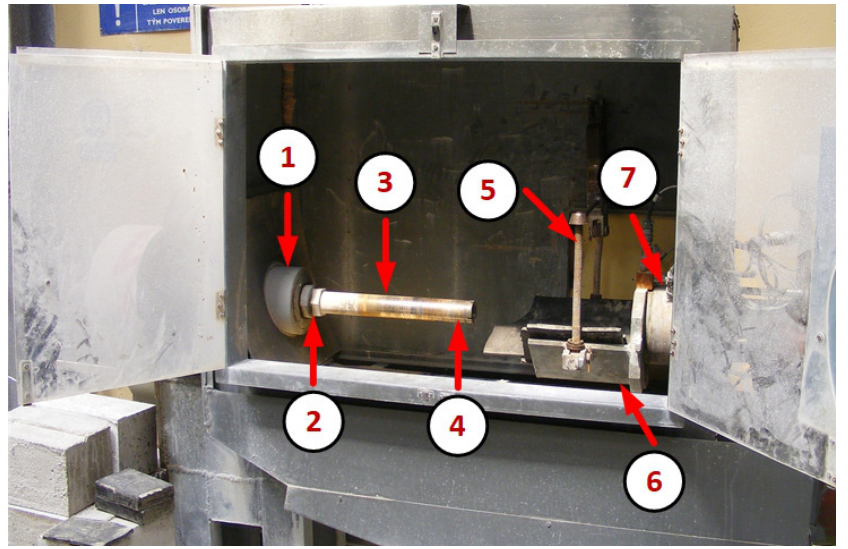
Figure 3. Detailed view to the drilling rig ( 1 —headstock, 2 —spindle drill, 3 —core barrel, 4 —drilling bit, 5 —clamping mechanism, 6 —centering sled clamping mechanism, 7 —head of the tensimeter